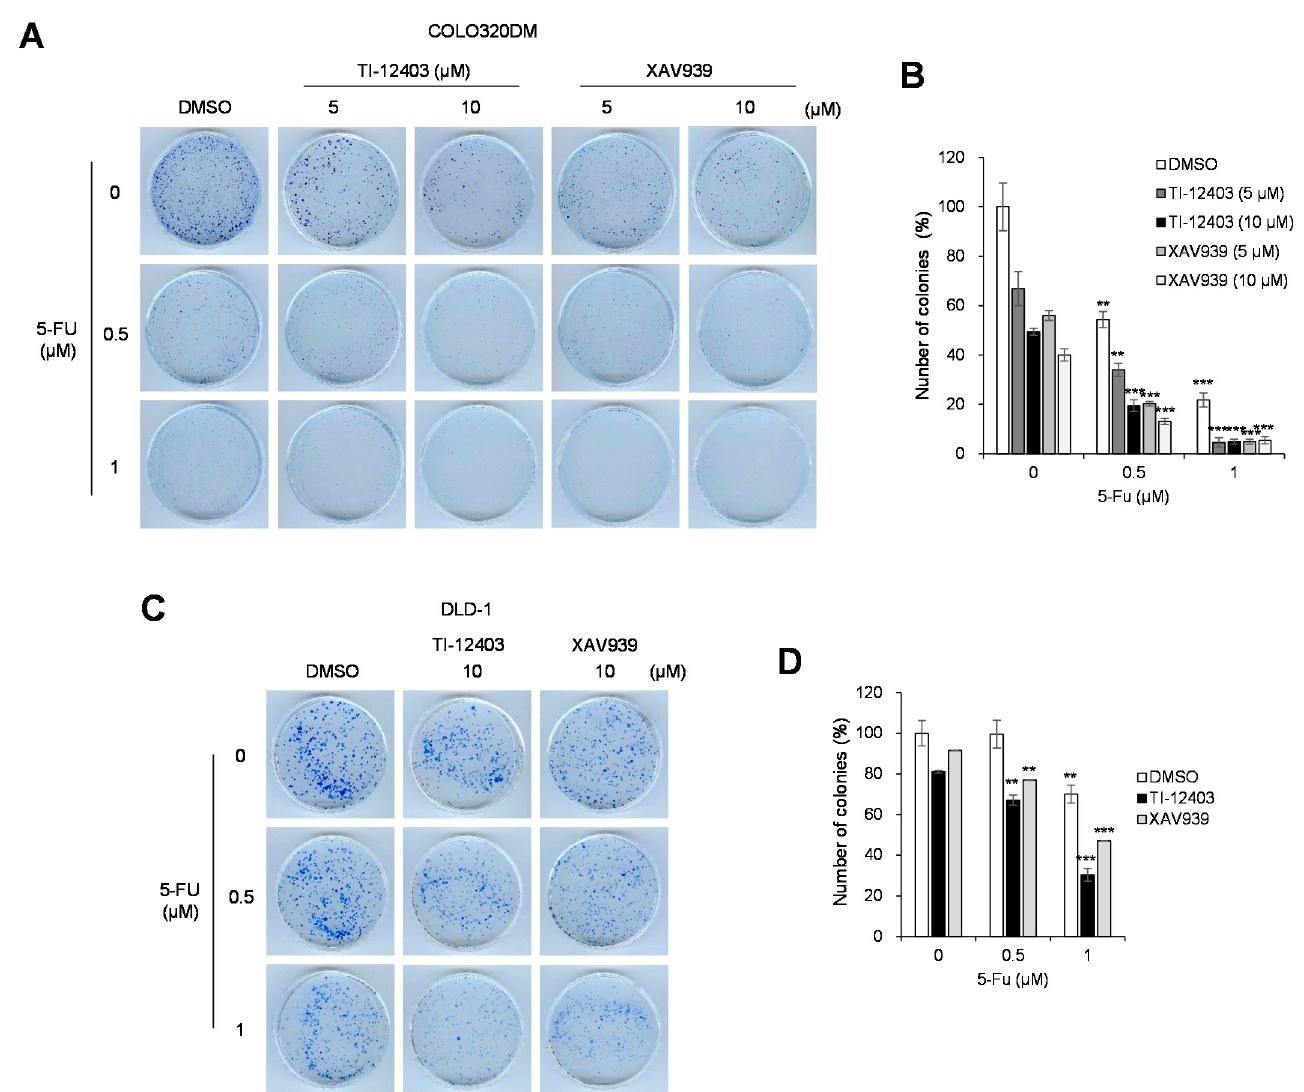
Figure 5. TI-12403 enhances chemosensitivity in COLO320DM and DLD-1 cells. ( A , B ) COLO320DM and ( C , D ) DLD-1 cells were treated with the indicated dose of TI-12403 for 2 h before treatment with the indicated doses of 5-fluorouracil (5-FU). Colonies were counted 10 days after 5-FU treatment. Colony numbers are normalized to the average value of the control growth values for each cell line. Colonies consisting of more than 50 cells were scored as survival colonies. Colony formation assay results are presented as bar graphs showing the number of colonies. The bar graph represents the normalized values to control group. ** p <0.01, *** p < 0.001 compared to each drug alone.